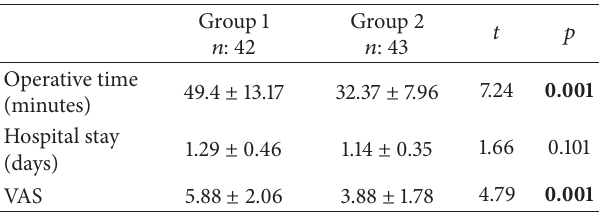
Table 3: Comparison of operative time, hospital stay, and VAS score between the